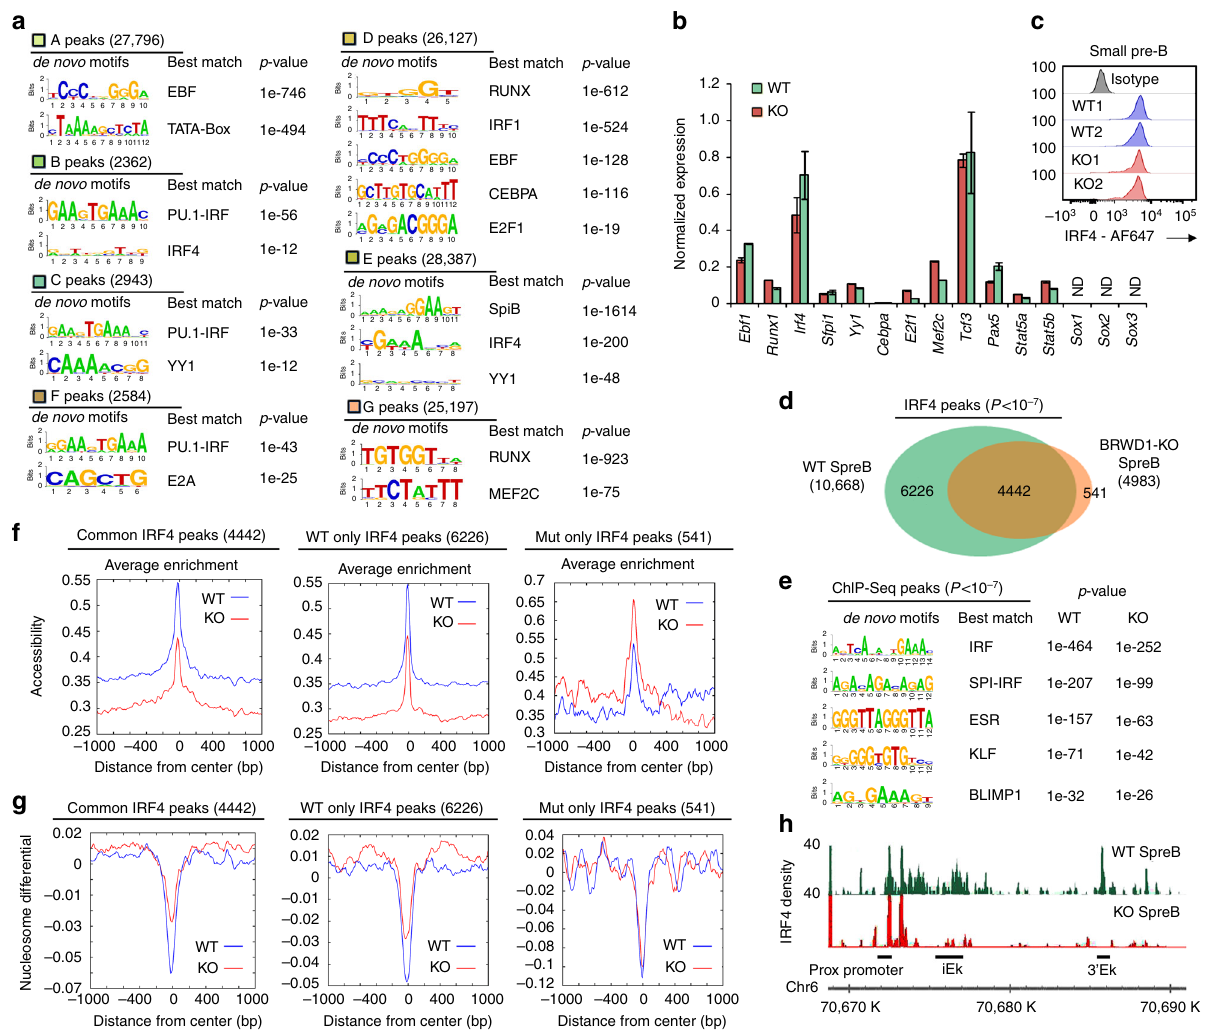
Fig. 4 BRWD1 determines the genomic targets accessible to TF critical for B-cell fate. a De novo DNA sequence motifs identi fi ed in different open chromatins regions described in Fig. 3a. b Quantitative mRNA expression of indicated transcription factors in puri fi ed WT and Brwd1 -/- small pre-B cells. c Flow cytometry analysis of intracellular total IRF4 in small pre-B cells isolated from WT and Brwd1 -/- bone marrow; gray-isotype-matched control antibody. d Overlap of IRF4 ChIP-Seq peaks ( P < 10 -7 ) from puri fi ed WT and Brwd1 -/- small pre-B cells. e De novo DNA sequence motifs identi fi ed in IRF4 ChIP-Seq peaks in WT and Brwd1 -/- small pre-B cells. f , g DNA footprint analyses of ± 1 kb region for WT and Brwd1 -/- small pre-B cells at common IRF4 peaks, WT-only IRF4 peaks and Brwd1 -/- only IRF4 peaks centered on 0 for accessibility ( f ) and nucleosome positions ( g ). h ChIP-Seq pro fi le of IRF4 at the intronic kappa enhancer (iEk) and 3 ’ kappa enhancer (3 ’ Ek) of immunoglobulin kappa ( Ig κ ) light chain locus in puri fi ed WT and Brwd1 -/- small pre-B cells. Data are from combination ( d ) of independent experiments ( n = 2) or are presented as average ± s.d. ( n = 2) ( b